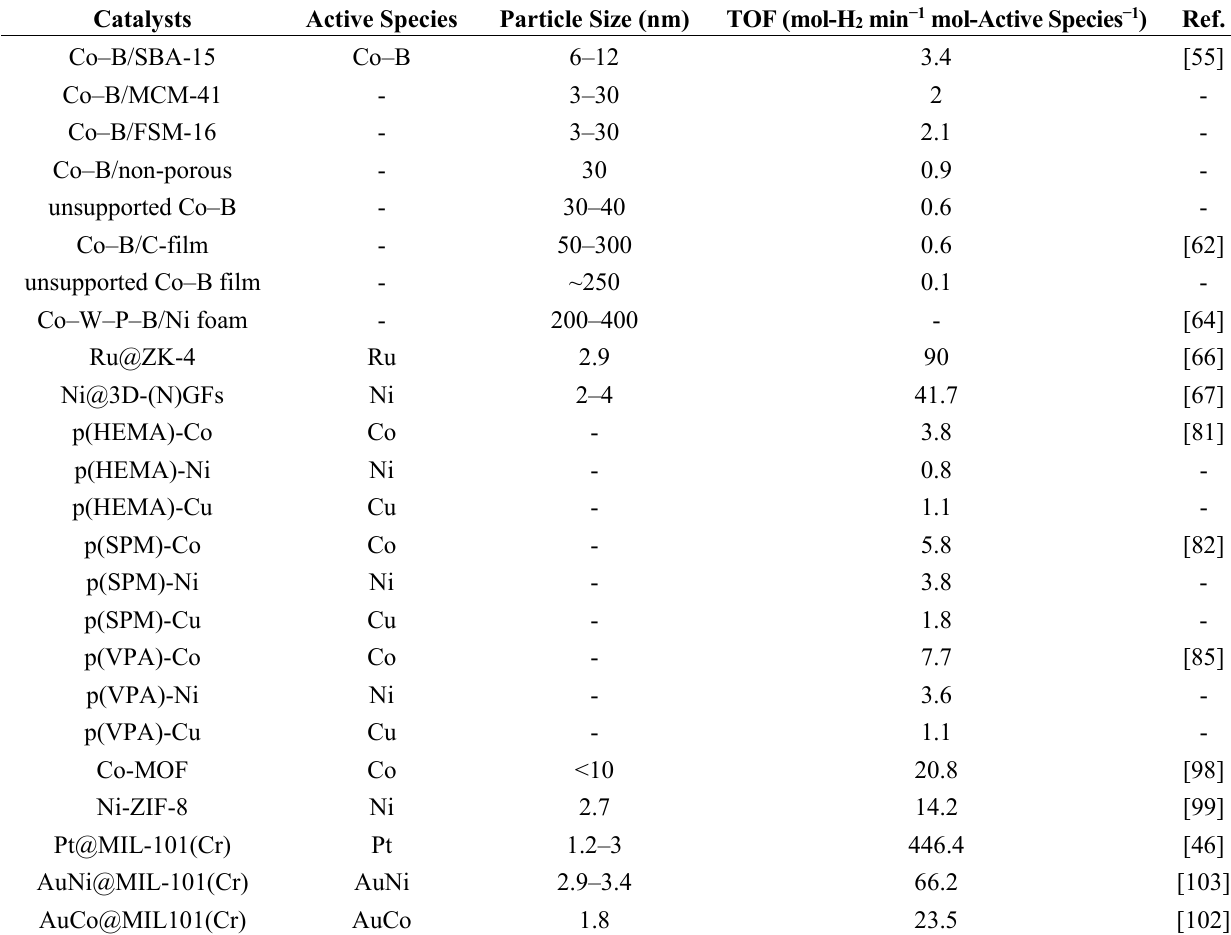
Table 1. Particle size of active species and turnover frequency (TOF) of various